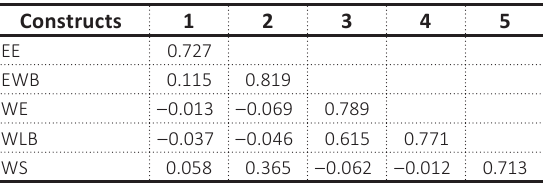
Table 4. The measurement model discriminant validity – Fornell-Lacker criterion